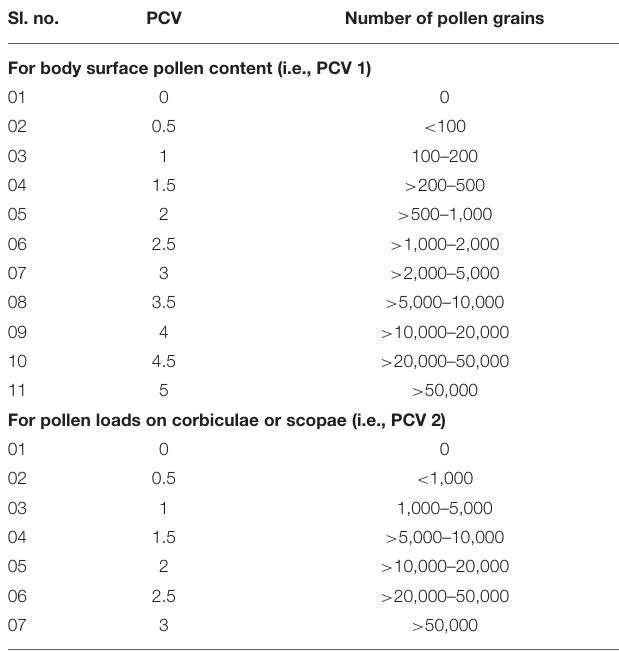
TABLE 1 | Pollen carrying value (PCV) is based on the number of pollen grains on visitor’s body surface (excluding pollen loads on corbiculae or scopae) and pollen loads on corbiculae or